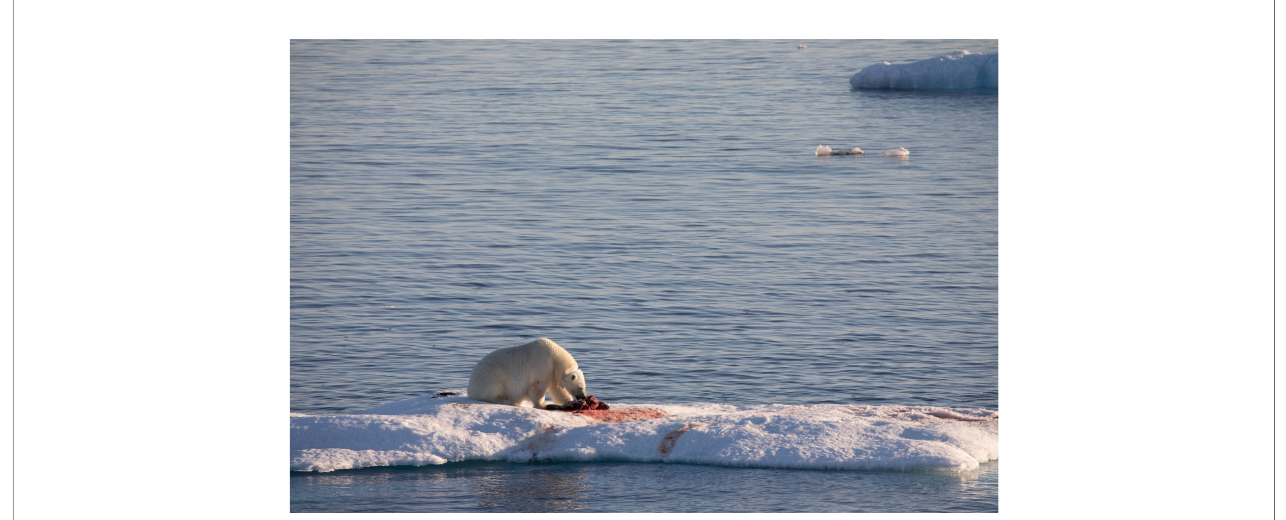
FIGURE 3 | A satellite-collared female polar bear in East Greenland feeding on a harp seal kill in July 2019. This bear was captured, and the collar deployed two years before the photo was taken. This bear would score high on a body condition index. Several scienti fi c studies have demonstrated that the presence of satellite telemetry devices does not impact body condition over the long term. Photo by Nick